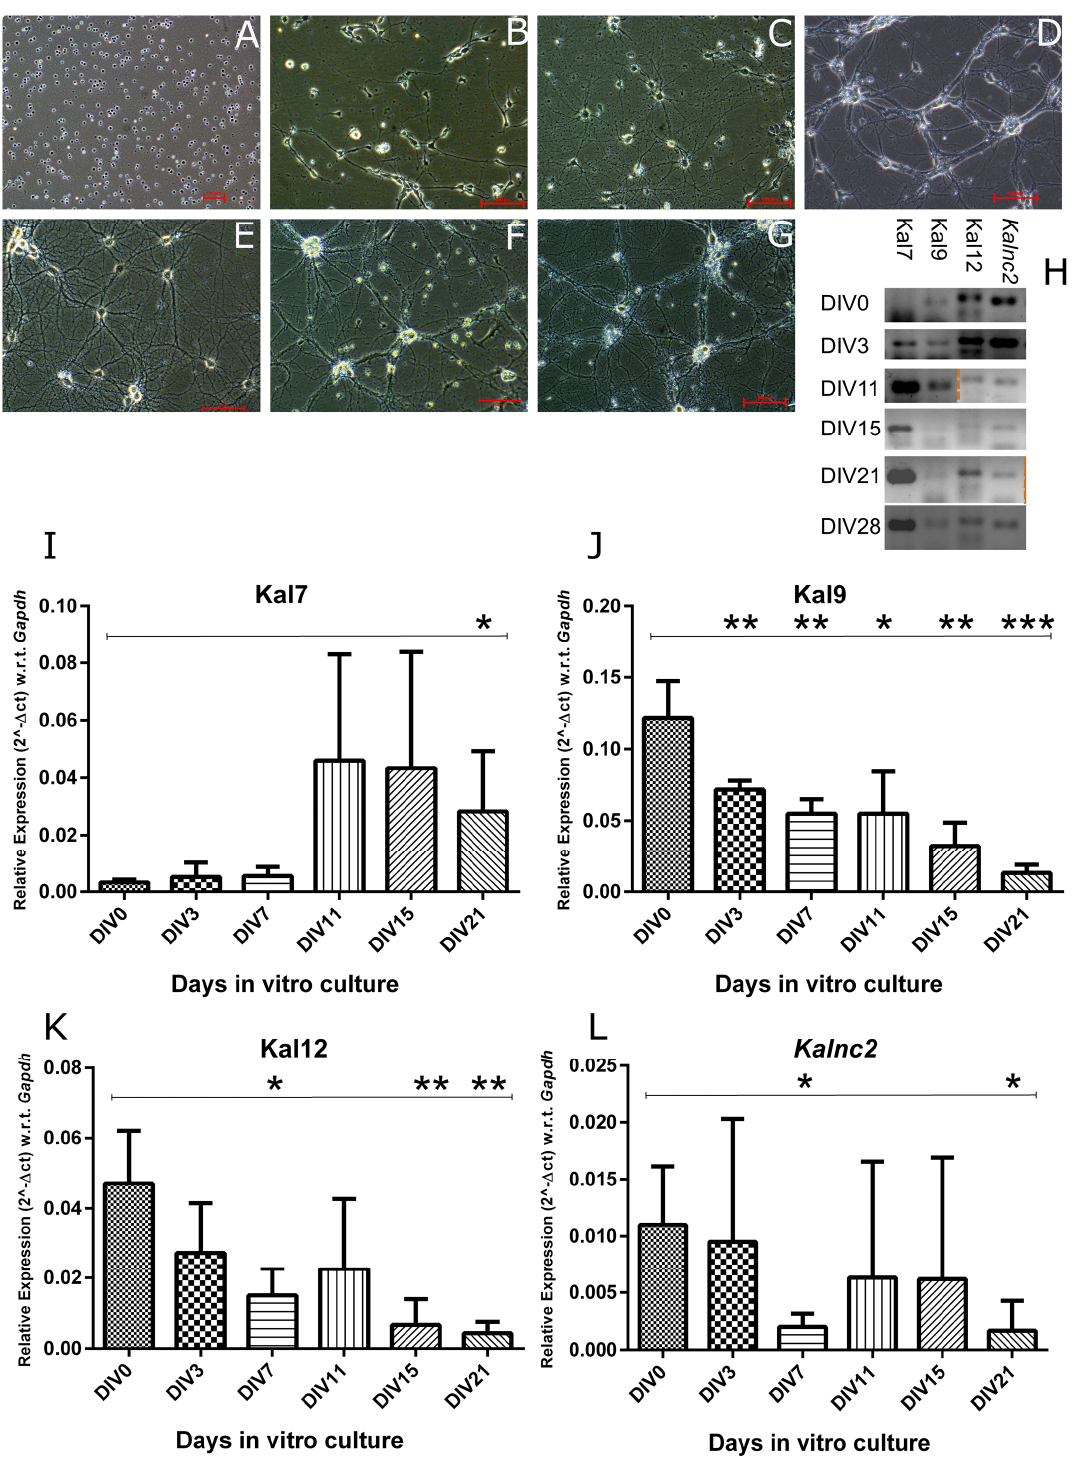
Figure 4. Kalnc2 expression is similar to that of Kal9 and Kal12, but opposite to Kal7. ( A – G ) Bright field images of mouse neural stem cell differentiation and maturation in neurons. ( A ) DIV0, ( B ) DIV3, ( C ) DIV7, ( D ) DIV11, ( E ) DIV15, ( F ) DIV21, and ( G ) DIV28; scale bare 100 µ m. ( H ) Endpoint PCR for Kalnc2 (110 bps) and Kalrn major coding transcripts: Kal7 (127 bps), Kal9 (125 bp) and Kal12 (140 bps) at different DIVs (DIV0, DIV3, DIV11, DIV15, DIV21 and DIV28). ( I – L ) Kal7, Kal9, Kal12, and Kalnc2 expressions were measured at DIV0, DIV3, DIV11, DIV15, and DIV21. DIV (Days of in vitro culture). (Data are shown as mean ± SD; N = 3 biological replicates; n = 3 technical replicates; t -test, * p < 0.05; ** p < 0.01; *** p <